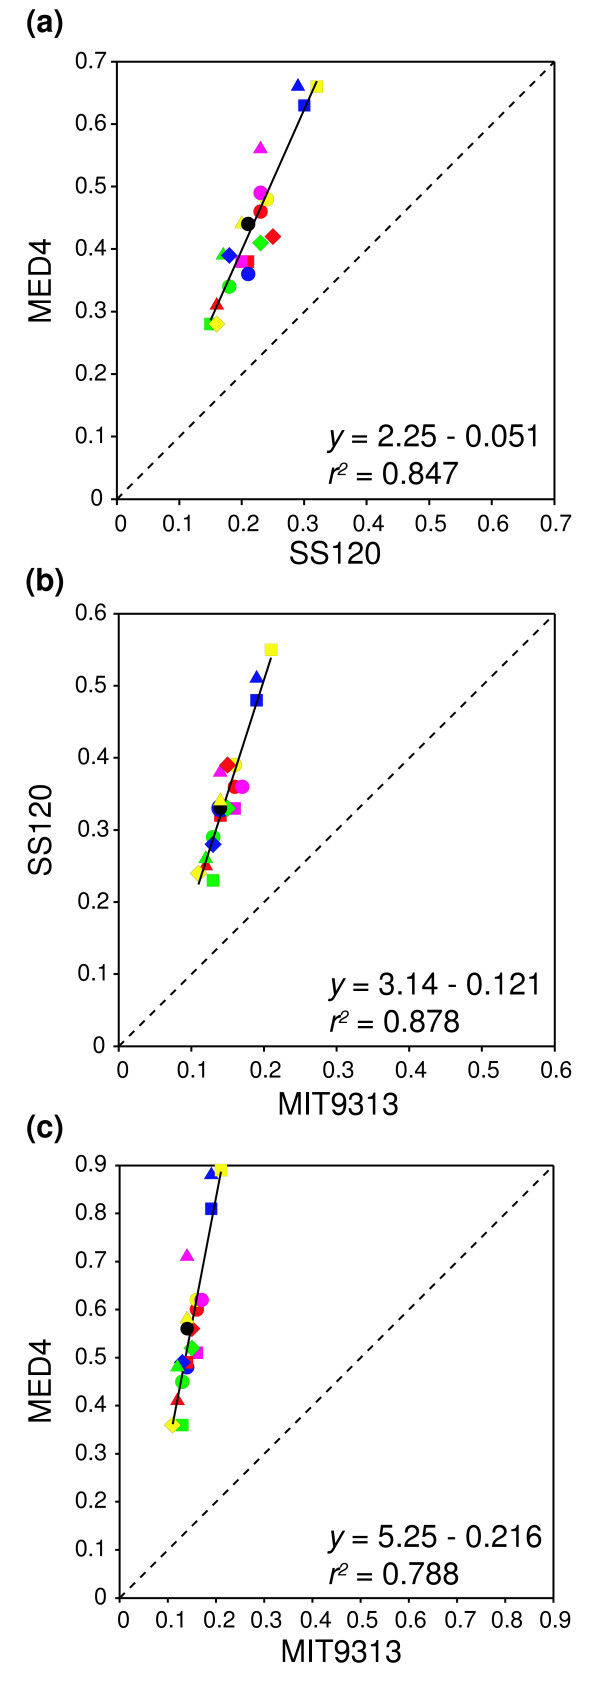
Amino-acid substitution rate per functional category. Branch lengths computed for each functional category between (a) MED4 and SS120, (b) SS120 and MIT9313 and (c) MED4 and MIT9313. In the three comparisons, branch-length values are aligned along a line with a slope much greater than 1, indicating that acceleration of the substitution rates occurs in every functional category. Axes represent the number of amino-acid substitutions per site. Red circle, amino-acid transport and metabolism; green circle, carbohydrate transport and metabolism; yellow circle, cell-cycle control; blue triangle, cell wall/membrane biogenesis; pink circle, coenzyme metabolism; red square, defense mechanisms; green square, energy production and conversion; yellow square, function unknown; blue square, general function prediction only; pink square, inorganic ion transport and metabolism; red triangle, intracellular trafficking; green triangle, lipid transport and metabolism; yellow triangle, nucleotide transport and metabolism; blue circle, posttranslational modification, protein turnover; pink triangle, replication, recombination and repair; red diamond, secondary metabolite biosynthesis, transport and catabolism; green diamond, signal transduction mechanisms; yellow diamond, transcription; blue diamond, translation; black circle, miscellaneous.